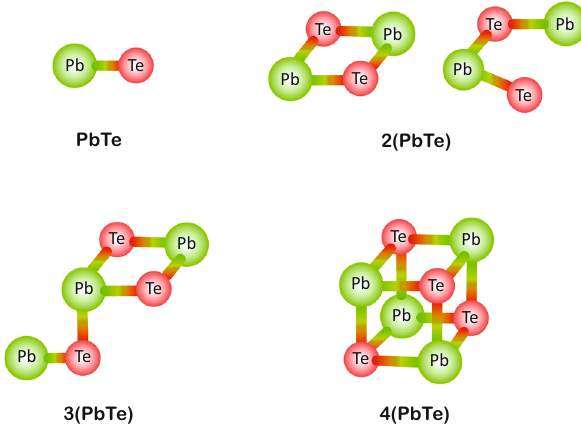
Figure 7: Possible examples of the covalent - type molecules, PbTe, 2 ( PbTe ) , 3 ( PbTe ) and 4 ( PbTe ) .